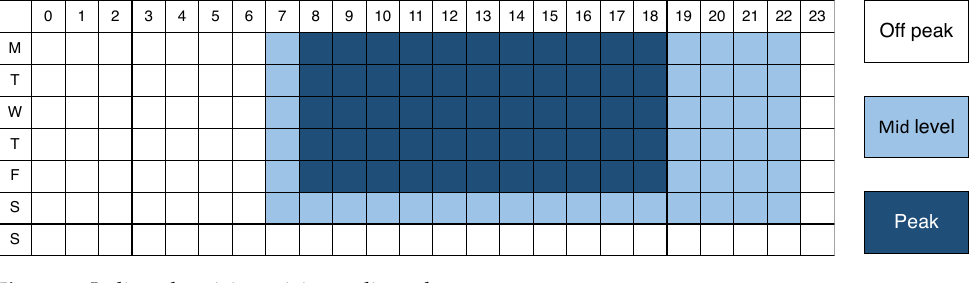
Figure 1. Italian electricity pricing policy scheme. Table 6. Electricity prices employed for LIMB reconfiguration.